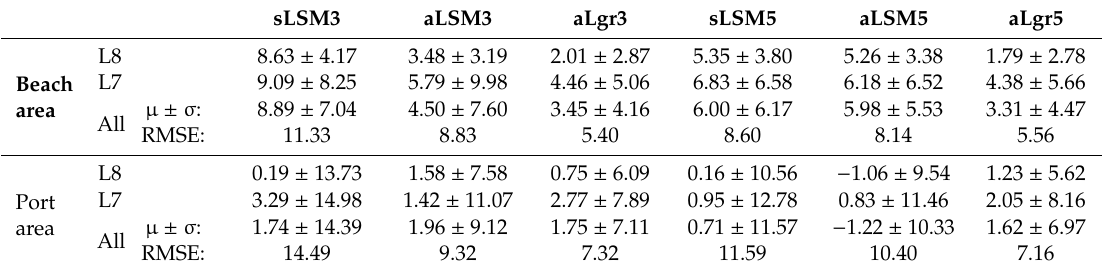
Table 3. Average ( µ ), standard deviation ( σ ) and RMSE values (in meters) describing the precision of di ff erent sub-pixel shoreline solutions (of Table 2) for the 17 analysed days (seven L8 and ten L7 images).